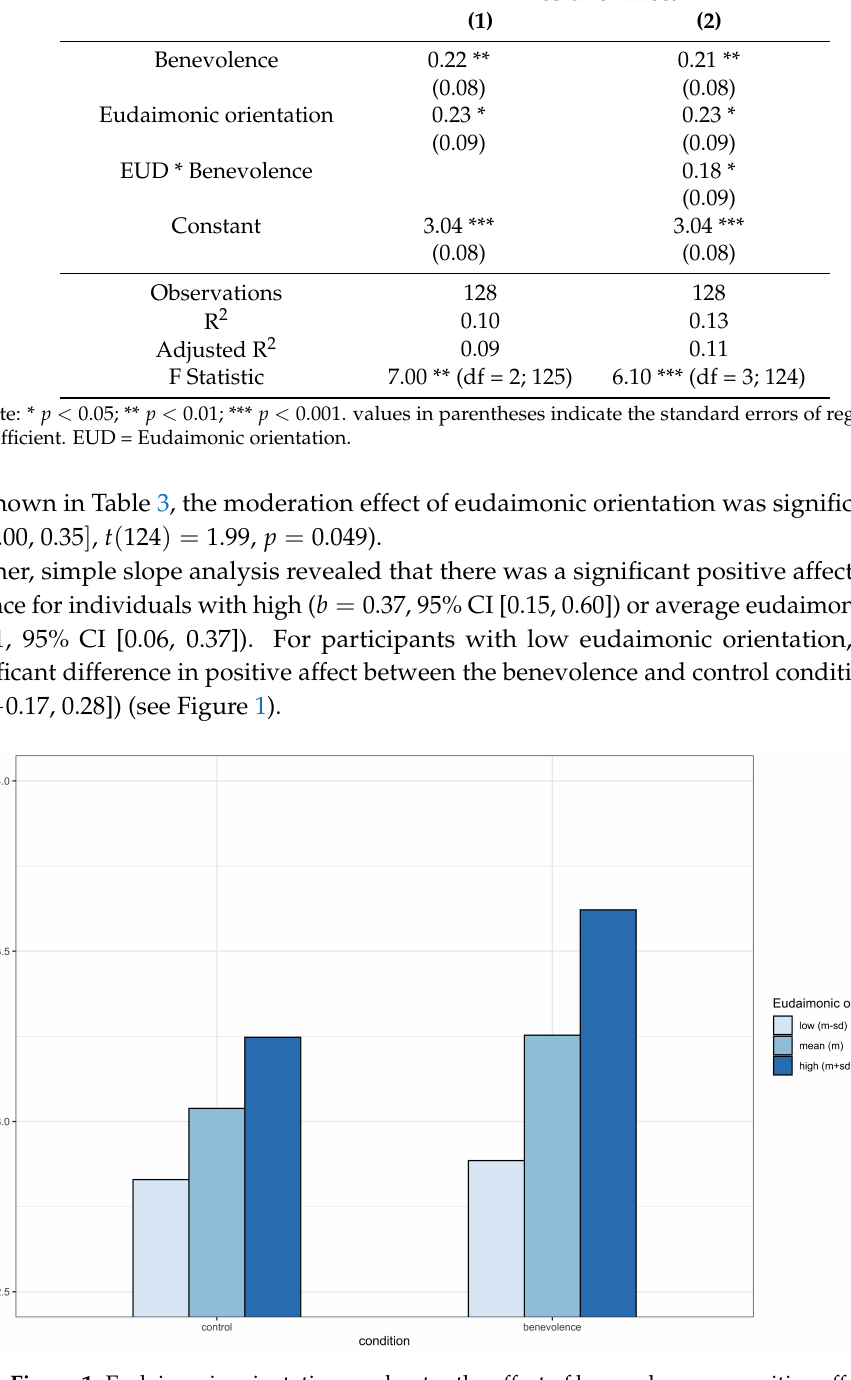
Figure 1. Eudaimonic orientation moderates the effect of benevolence on positive